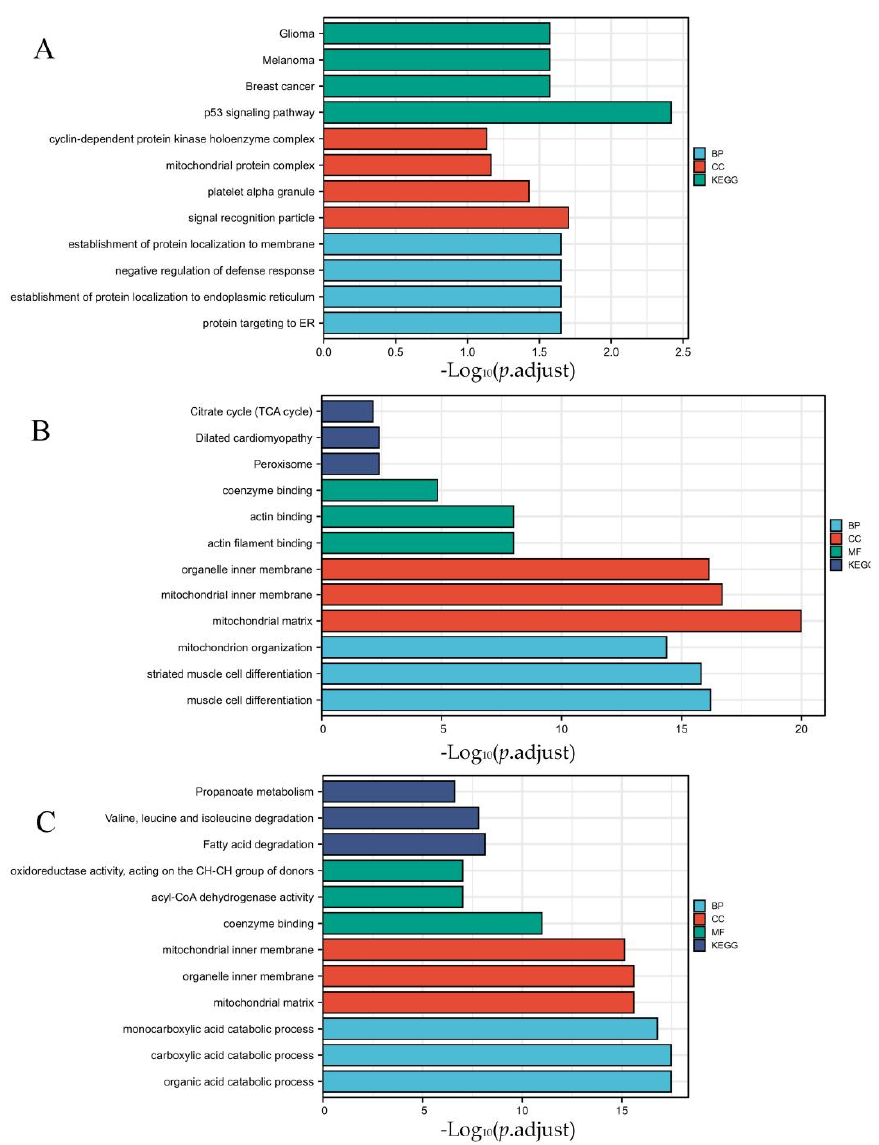
Figure 5. GO and pathway analysis of DEGs in VO and TAC groups with same regulation, oppo- site regulation, and no interaction. DEGs were divided into two functional groups, including BP and CC. GO: Gene Ontology; BP: biological process; CC: cellular component; KEGG: Kyoto Ency- clopedia of Genes and Genomes; DEGs: differentially expressed genes. ( A ) is GO analysis of DEGs with same regulation. ( B ) is GO analysis of DEGs with opposite regulation. ( C ) is GO analysis of DEGs with no interaction.